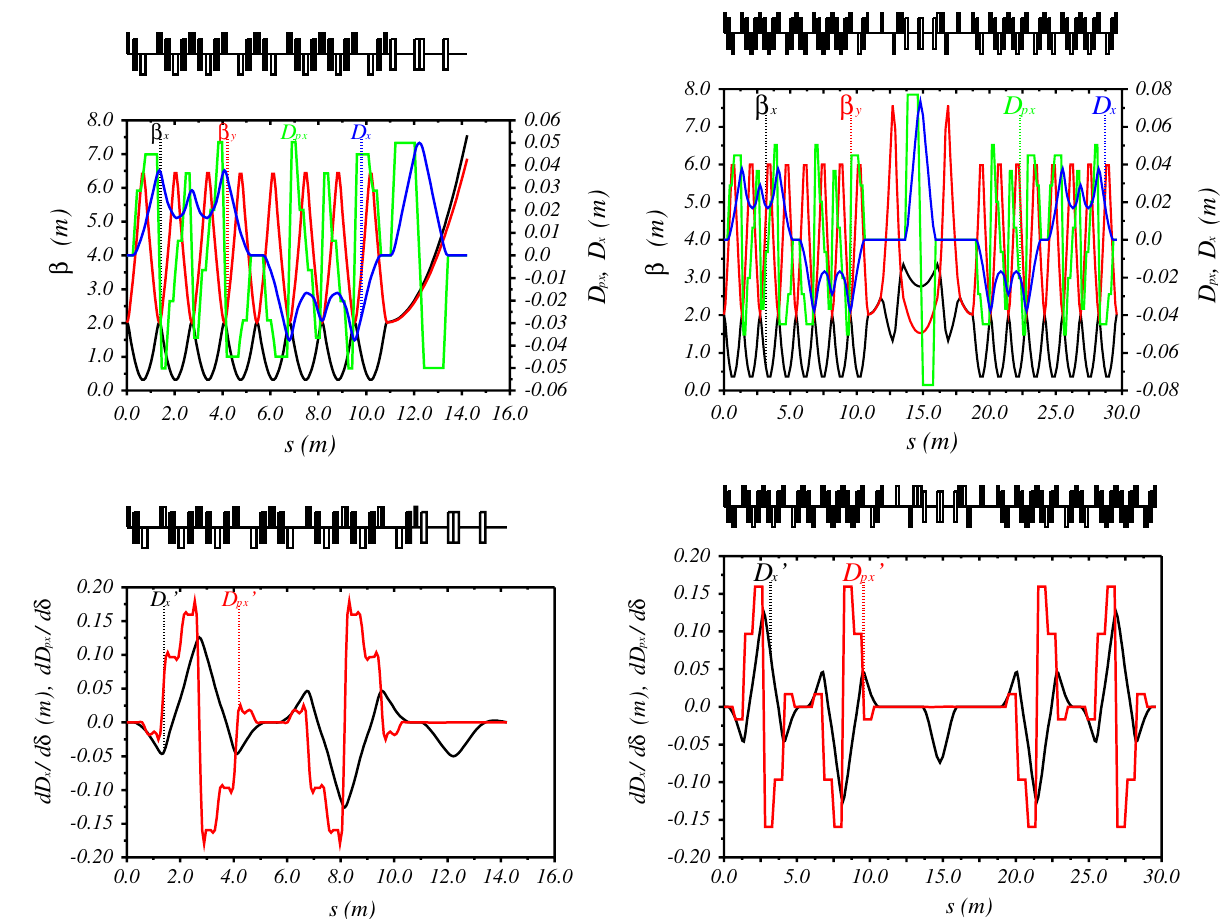
FIG. 7. First order and second-order optics of a dogleg beam line and a bypass beam line. Left top: First order dispersion and beta functions of the dogleg beam line. Left bottom: Second-order dispersion T 166 and angular dispersion T 266 of the dogleg beam line. Right top: First order dispersion and beta functions of the bypass beam line. Right bottom: Second-order dispersion T 166 and angular dispersion T 266 of the bypass beam